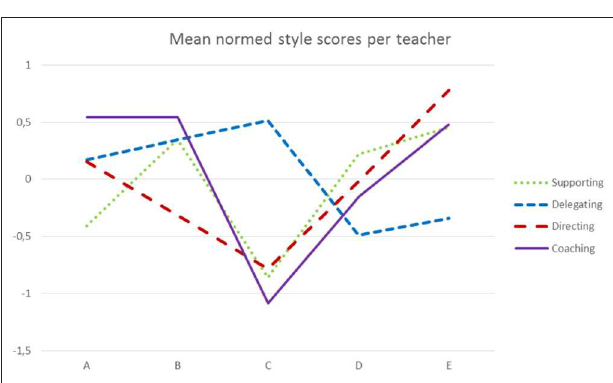
FIGURE 6 | Mean normed style scores per teacher. This figure shows that there is a difference in the teaching style of teachers. C uses the delegating style most; in contrast, E used the other styles more, and other teachers used a mix of styles.